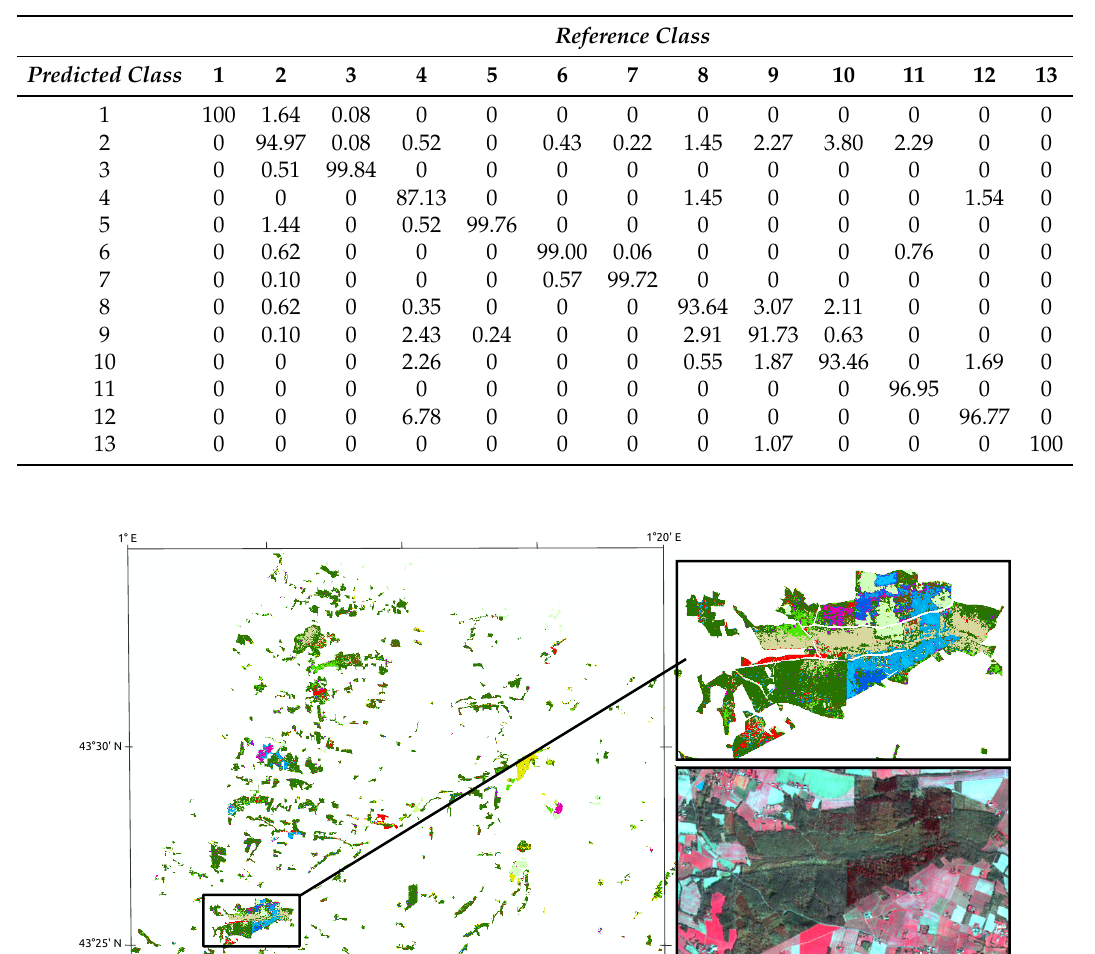
Table 4. Confusion matrix between the 13 tree species (level 3) computed in % and averaged over 25 repetitions. The matrix is based on the best classification obtained using the smoothed W bands dataset and the SVM classifier. Rows and columns represent pixels in the classification and the reference respectively. The class labels are: 1 (Silver birch), 2 (Oak), 3 (Red oak), 4 (Douglas fir), 5 (Eucalyptus), 6 (European Ash), 7 (Aspen), 8 (Corsican pine), 9 (Maritime pine), 10 (Black pine), 11 (Black locust), 12 (Silver fir), 13 (Willow).